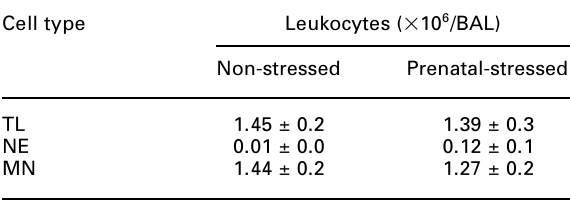
Table 1. Total and differential leukocyte counts in the bronchoalveolar lavage (BAL) fluid from non-sensitized offspring rats, either non-stressed or prenatally stressed